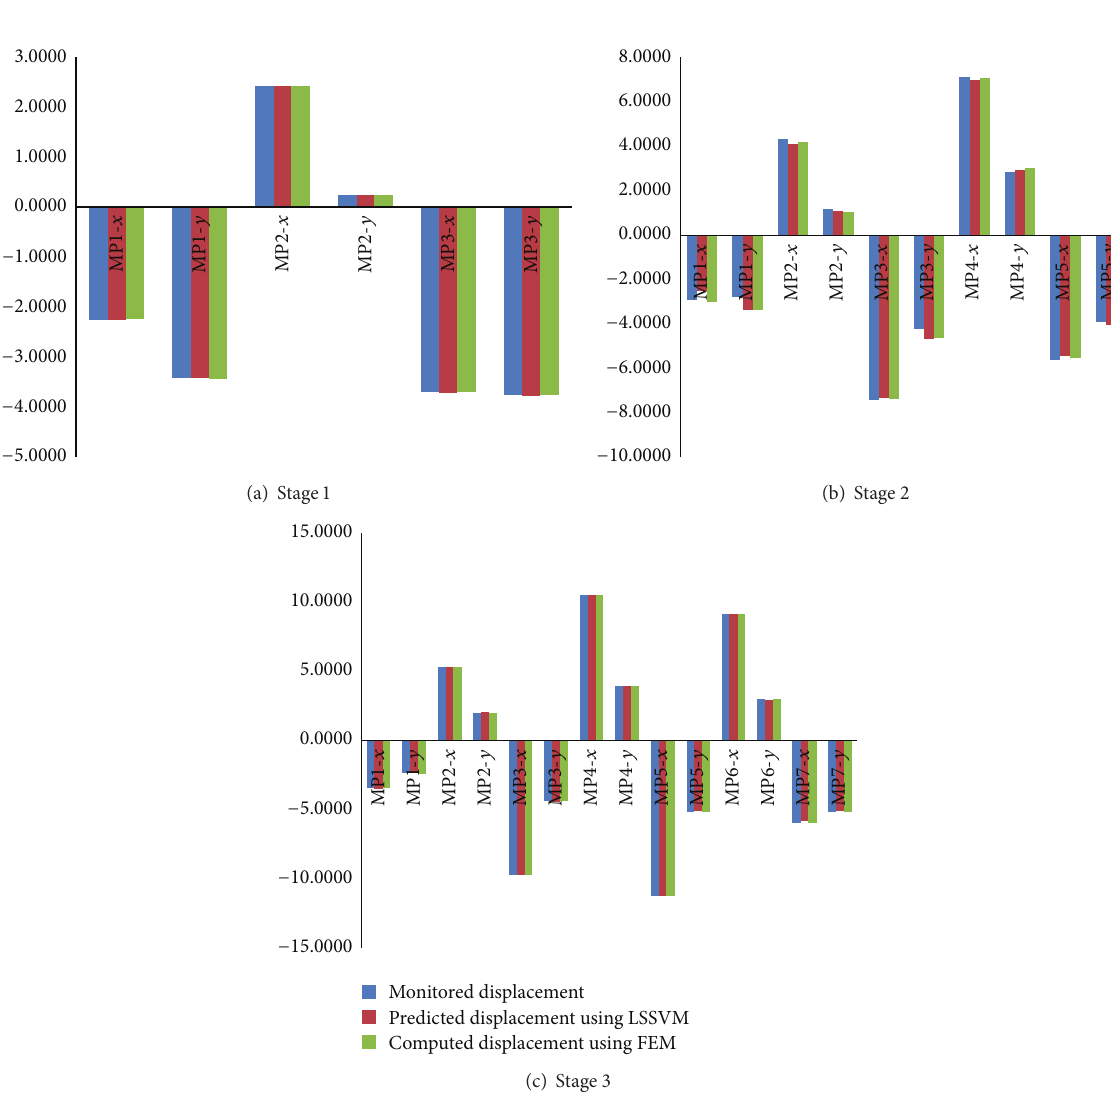
Figure 13: Predicted displacement using LSSVM with calculated displacement using theory and identified